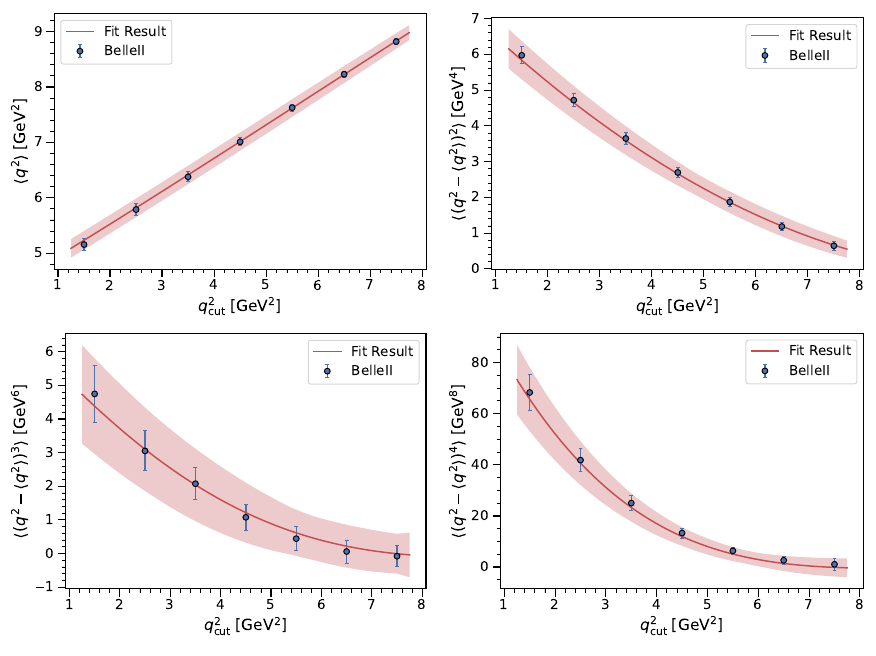
Figure 17 . Fit projections for q 2 moments using Belle II data only.